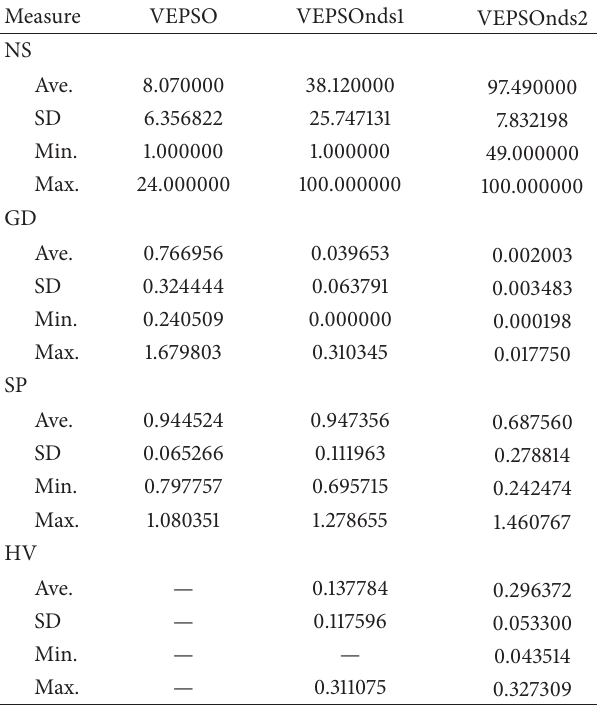
Table 2: Algorithm performance tested on ZDT2 problem.